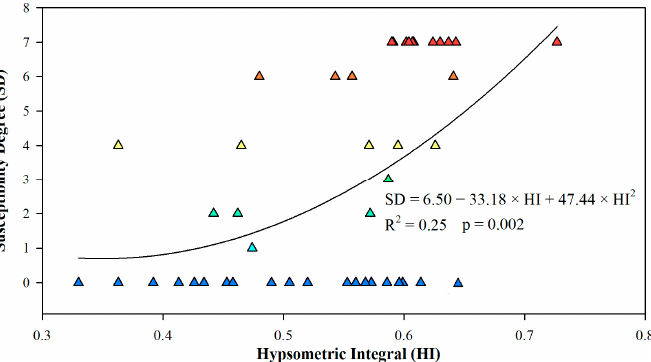
Figure 13. Relationships between HIs and SDs. HIs represent the geomorphic development status of gullies, which are calculated quantitative values. SDs are the susceptibility level defined by us, which can be considered as semi-quantitative values. We use different colors to distinguish different types of debris flow gullies. According to the regression equation, with the increase in HIs, the SDs of debris flow gullies show an increasing trend, indicating that the gully is more likely to suffer from debris flows. The R 2 of the fitting model of HIs and SDs is 0.25, and p is 0.002. The formula in the figure is only a result that we try to fit. Since there are no continuous values on the axes, it is not ruled out that there is a better fitting equation.